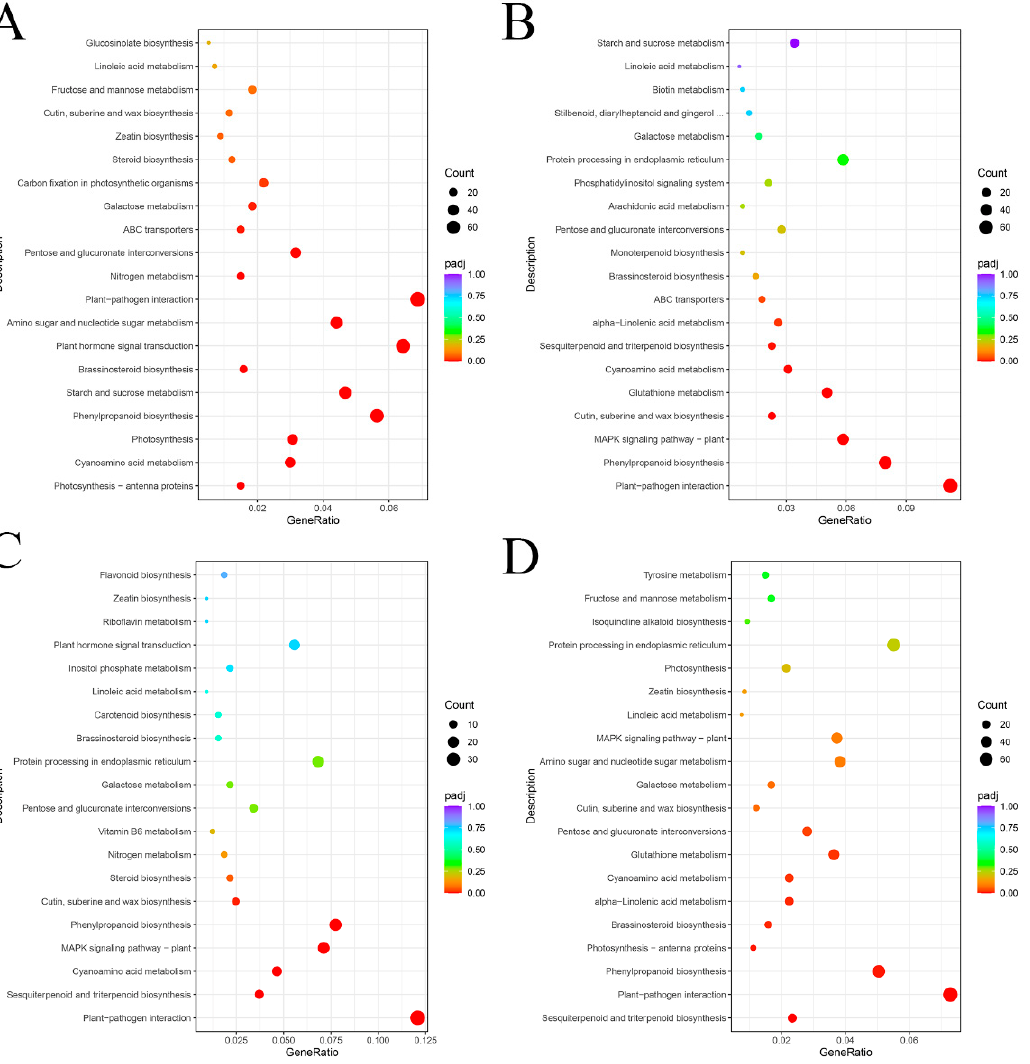
Figure 8. Kyoto Encyclopedia of Genes and Genomes (KEGG) pathway enrichment analysis of DEGs in response to different stress treatments. ( A ) CK vs. CK-D; ( B ) LA vs. CK; ( C ) LA-D vs. CK-D; ( D ) LA-D vs. LA. The X-axis shows the rich factor. Green represents a high q value, and red represents a low q value. The Y-axis shows the top 20 KEGG pathways. The bigger the size of the spot, the greater the number of DEGs